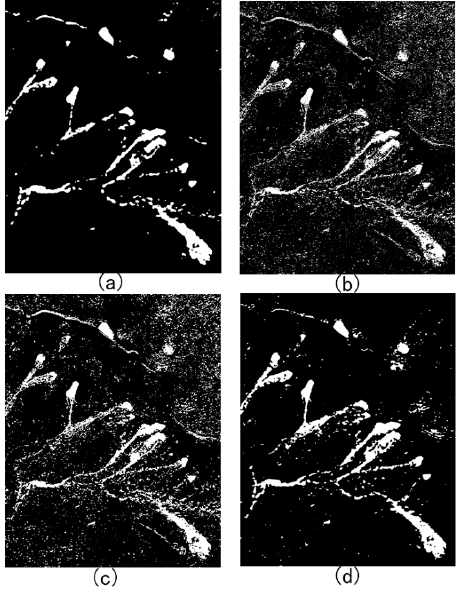
Figure 13. Second dataset: CDMs obtained by: ( a ) CD_PCA_Kmeans [1]; ( b ) CD_MLS [2]; ( c ) Semi_FCM method [3]; and ( d ) the proposed framework. Table 2. Change Detection Quantitative Evaluation (%) on the Second Dataset (more details can be tracked in Table S2.).